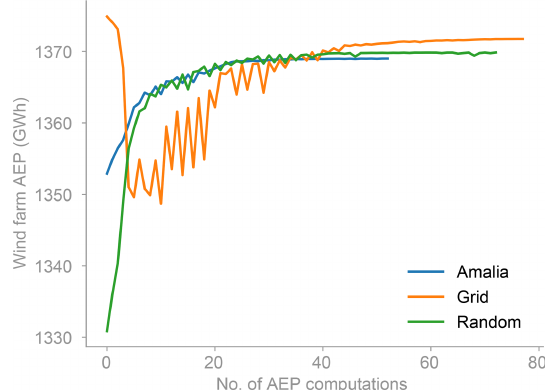
Figure 12. Convergence history of the optimization for the differ- ent starting layouts. The convergence history is for the layouts in Fig. 11.